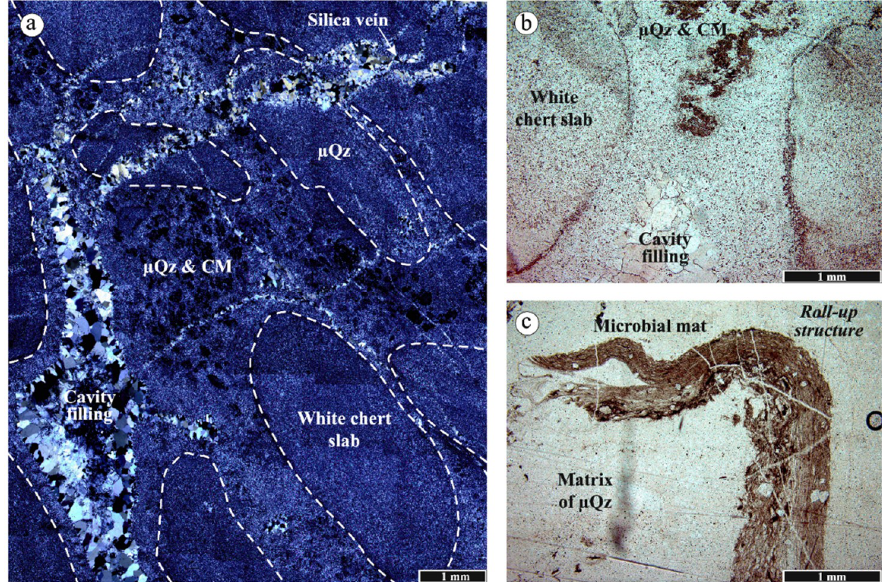
Figure 10. Optical microscopy of a slab conglomerate with slabs highlighted by white dotted lines. ( a , b ) Slabs are sub-rounded and consist of pure micro to mesoquartz ( < 2 µ m to < 20 µ m) with their border commonly outlined by carbonaceous matter concentrations. The matrix is made of microquartz with a variable amount of carbonaceous matter. Part of the matrix shows cavity-filling texture: microquartz in contact with slabs that may conserve traces of chalcedony. Then, macroquartz when going away from chert fragments is visible. ( c ) Remarkable example of a microbial mat fragment softly deformed with a roll-up structure and local detachment at the interface between a packed outer zone and a less packed inner zone. (CM = Carbonaceous matter, µ Qz = Microquartz).